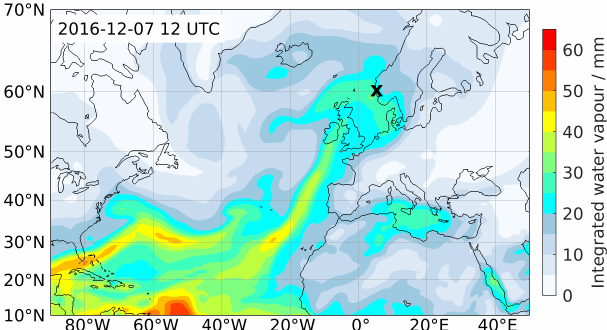
Figure 1. Vertically integrated water vapour (IWV) for the atmo- spheric river event occurring at 12:00UTC 7 December 2016 in the ERA-Interim analysis. The measurement site at Bergen is indicated with a black